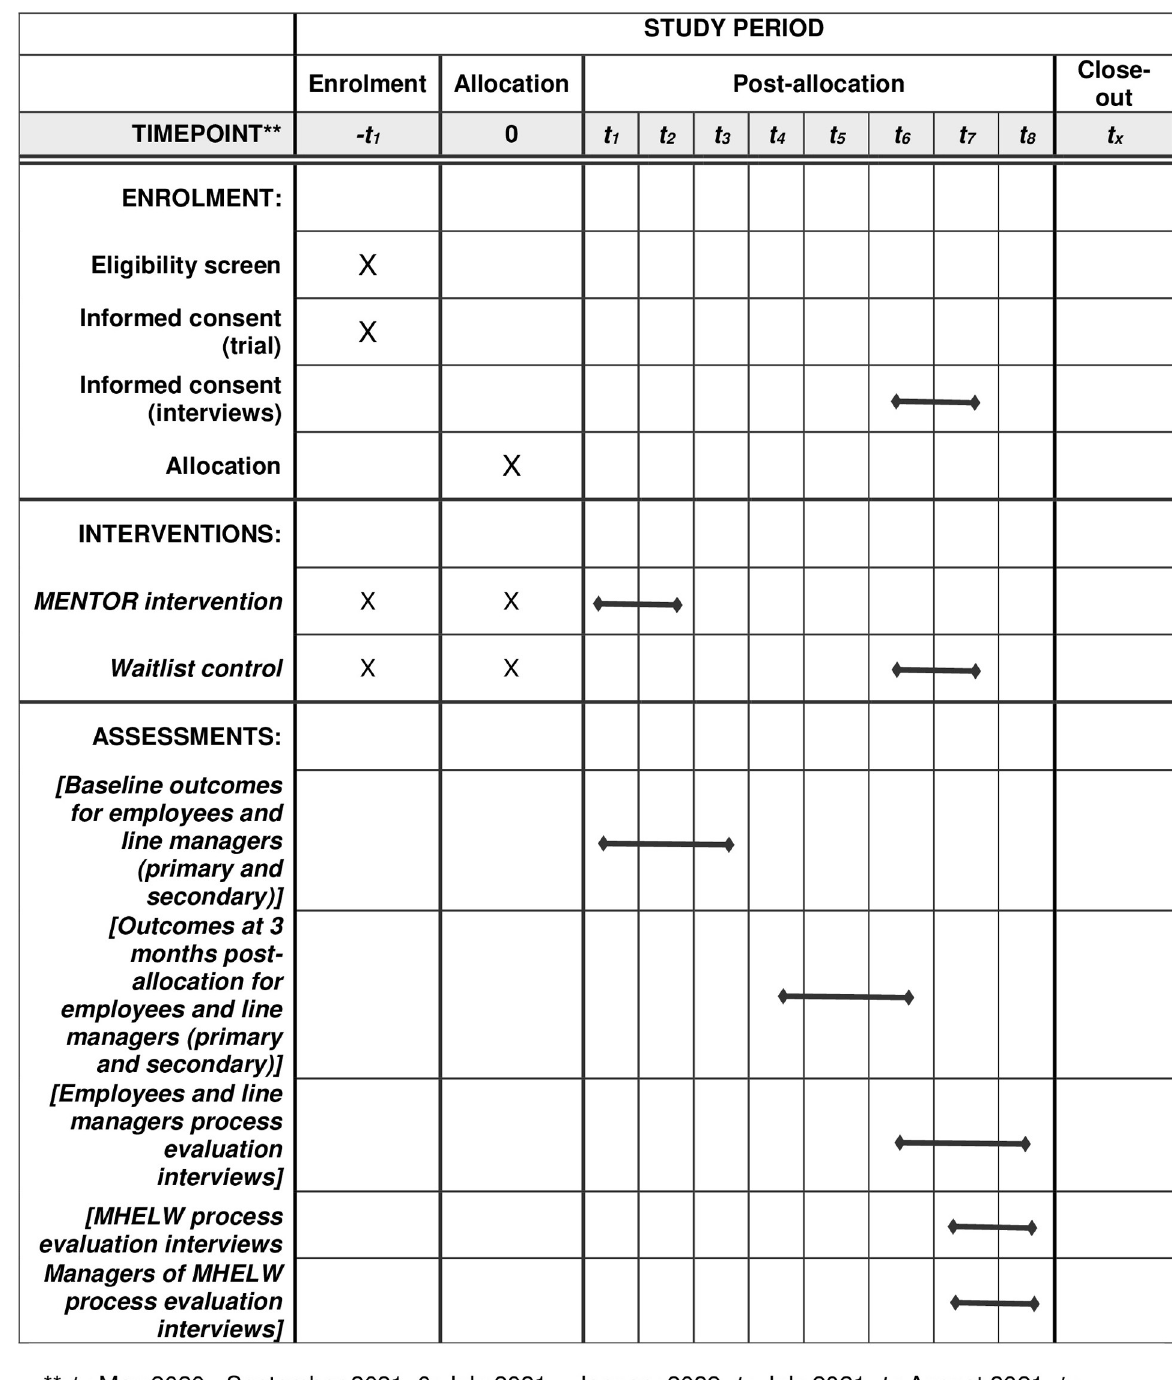
Fig 1. Recommended content for the schedule of enrolment, interventions, and assessments.